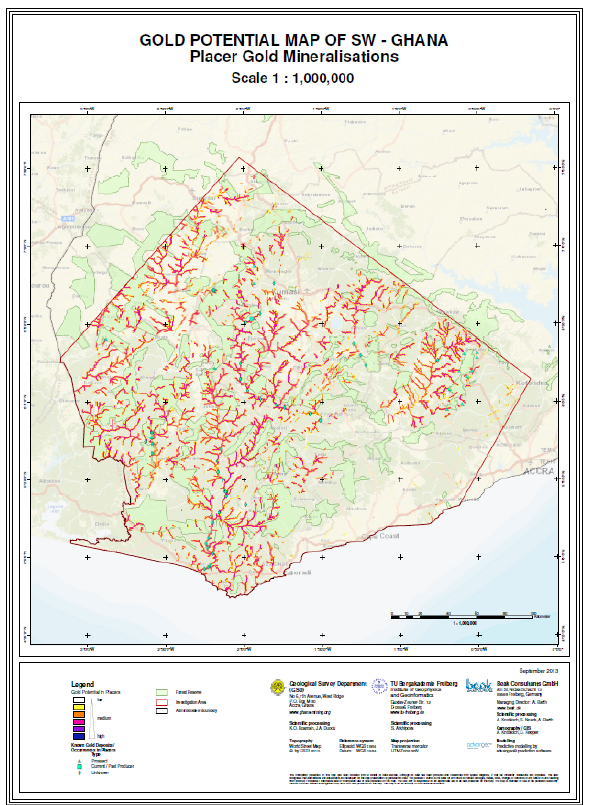
Figure 11. Placer Gold Potential Map 1.1,000,000